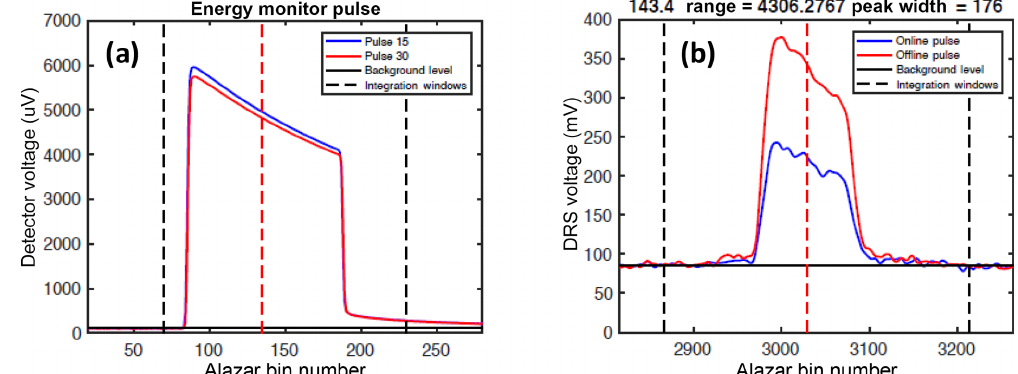
Figure 7. The lidar-transmitted pulse shape (a) and the recorded echo pulse shape returned from a dense cloud top (b) . The solid blue lines are for pulse #15, which is near the CO 2 absorption line center, and the solid red lines are for pulse #30, which is in the line wing. Horizontal black lines are signal baselines, and vertical dashed lines indicate signal integration windows. The dashed red lines in the middle are the integration center position in defining the centroid cloud height. Range unit is